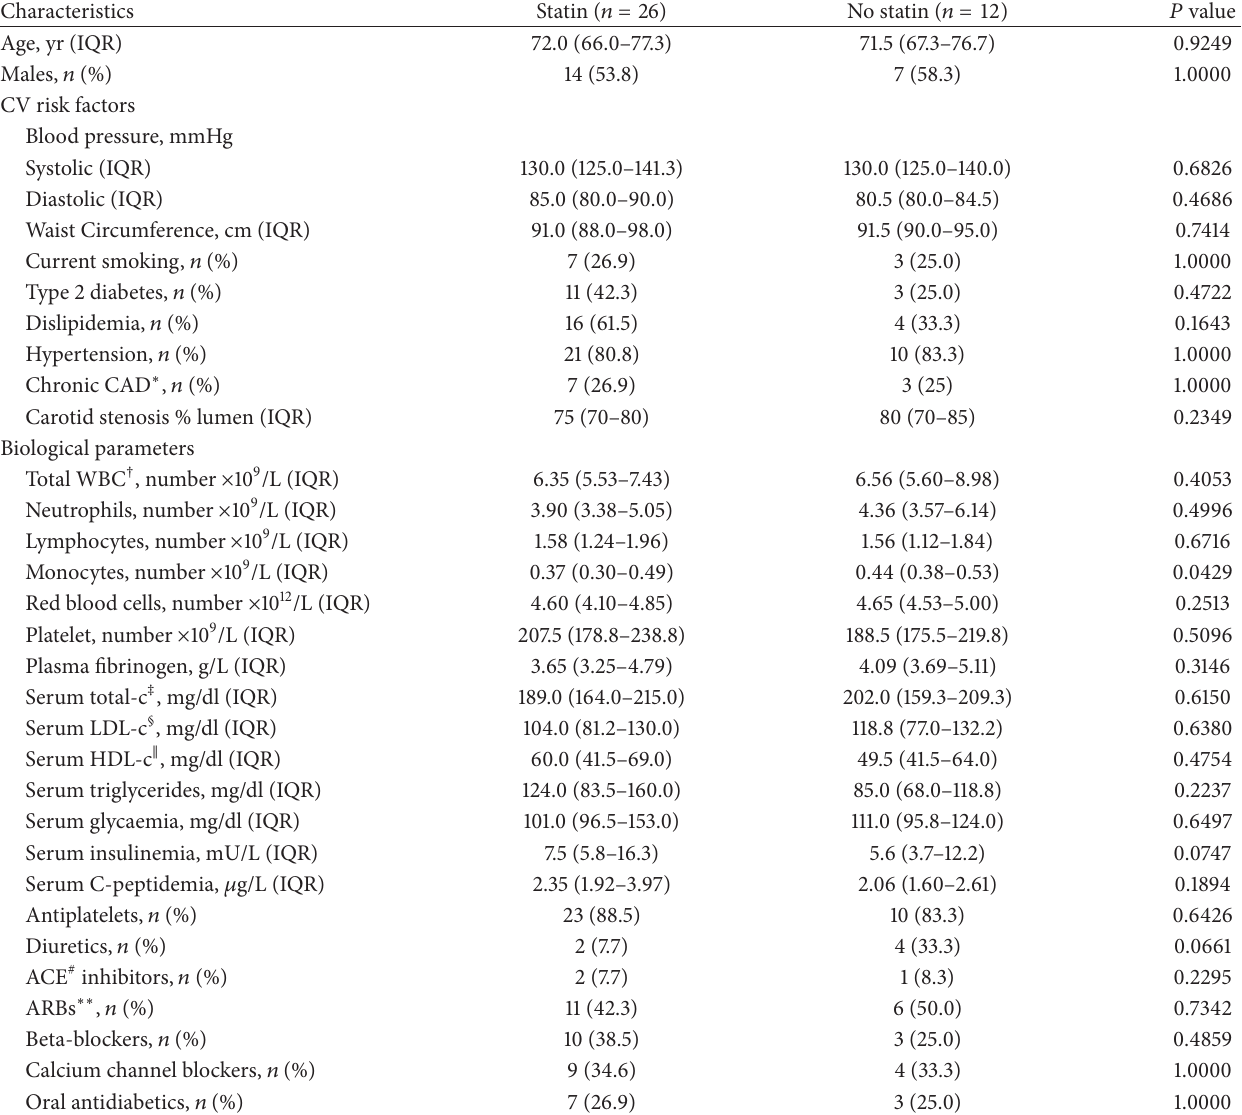
Table 1: Clinical characteristics and medications of the study